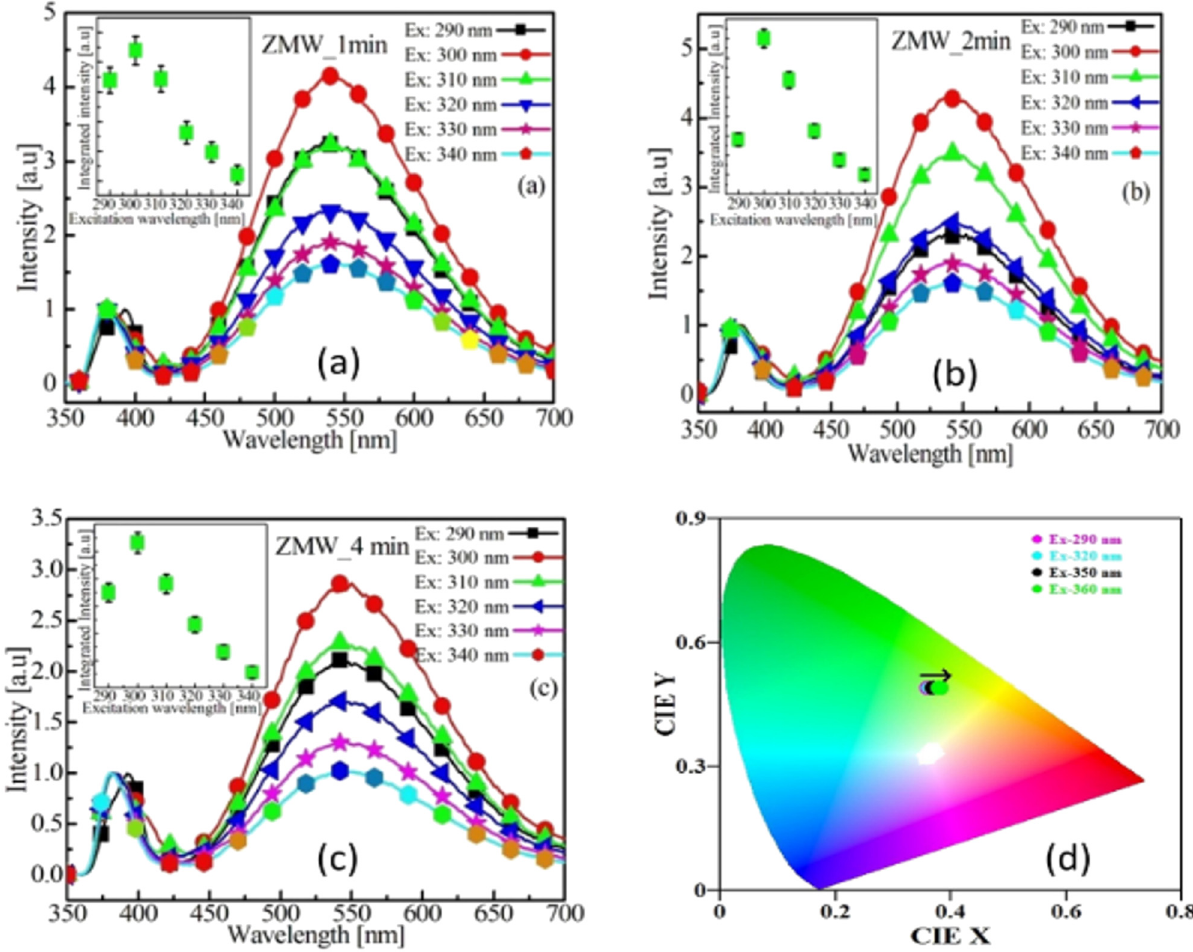
Figure 6: Excitation wavelength - dependent normalized PL spectra corresponding to the samples grown for microwave synthesis time of ( a ) 1 min, ( b ) 2 min, and ( c ) 4 min. Insets show the variation of integrated visible PL intensities as a function of excitation wavelength for all the samples. ( d ) Color chromaticity diagram for the sample corresponding to ( a ) . Reproduced with permission from Elsevier [ 163 ]